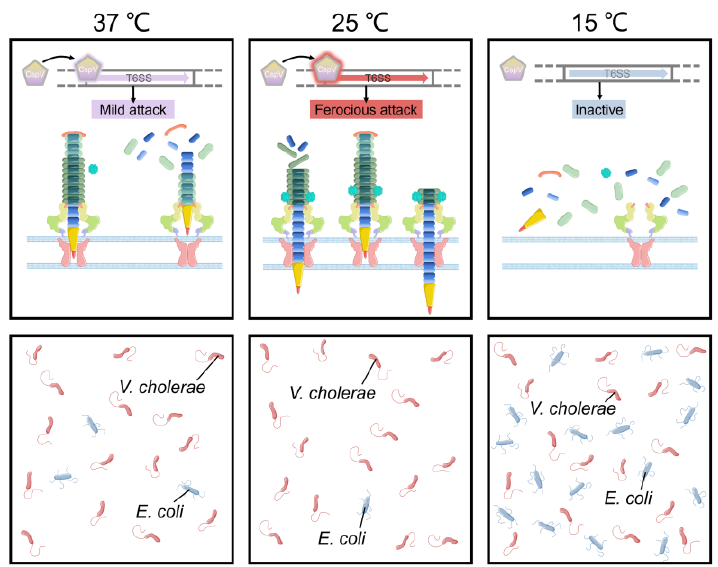
Figure 4. T6SS-mediated temperature adaptation and competition. The expression of T6SS-related genes in V. cholerae is regulated by temperature. V. cholerae showed significantly different virulence at different temperatures.